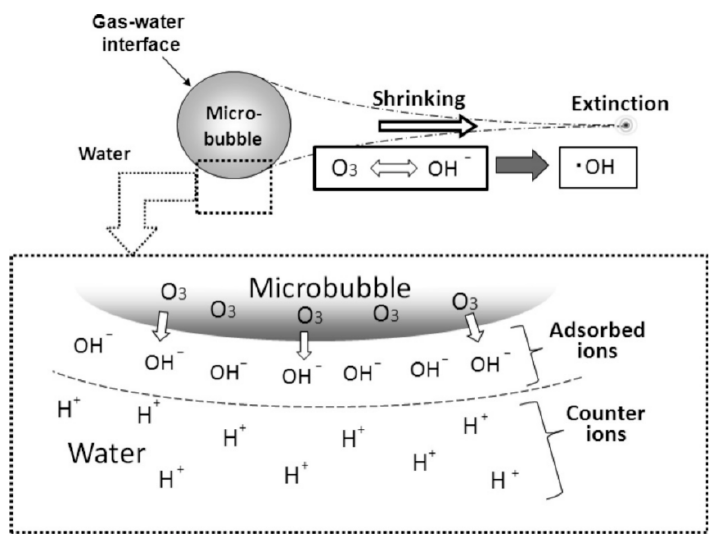
Figure 2. Mechanism of hydroxyl radical production by ozone microbubbles [81]. Reprinted with permission from Ref. [81] .